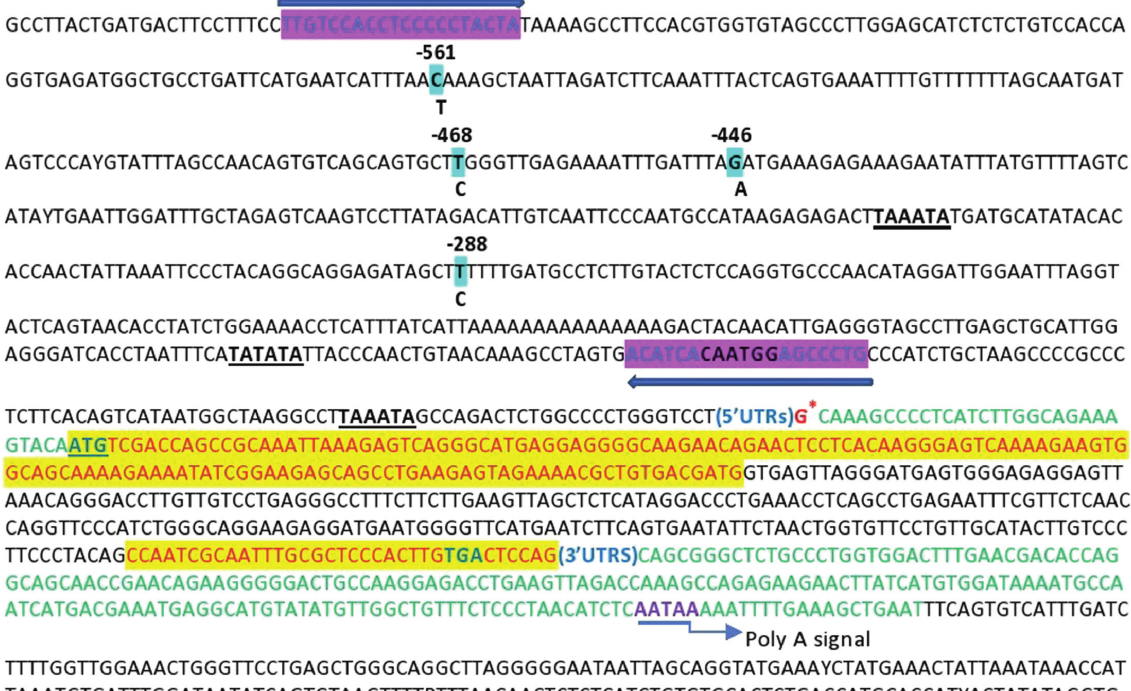
Figure 1: TNP1 genomic DNA sequences and primers for PCR amplification and sequencing. The recognition site nucleotide sequences, i.e., TATA box nucleotide, are highlighted. Shadowed letters represent single SNPs, while minor alleles are noted beneath the nucleotide. The transcription start site is shown with an asterisk. The arrows above and below the DNA sequence represent the primers employed for polyA- additional signal PCR amplification (the polyA signal from the straight arrow is added to the TNP1 mRNA). Yellow areas represent axons in the TNP1 gene.